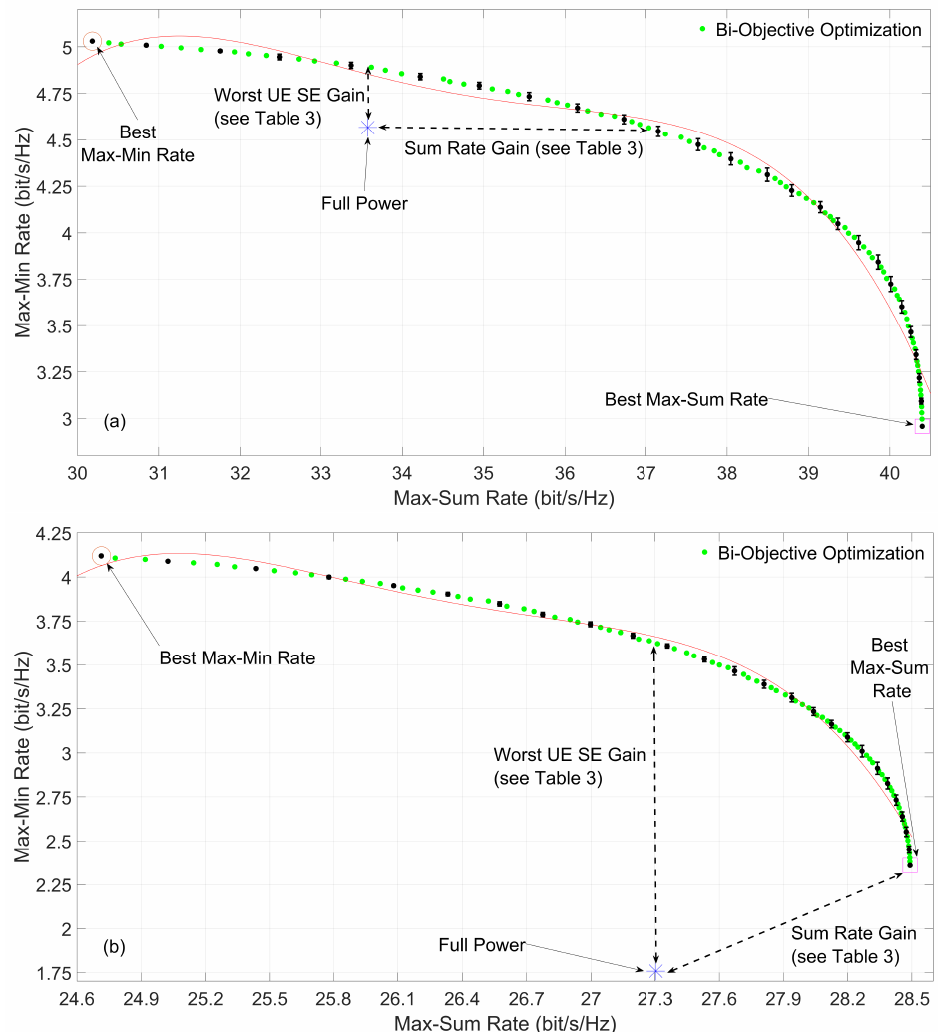
Figure 4. Bi-objective power optimization, max–min fairness and max–sum rate OF in a low UE density RS network with ( a ) high and ( b ) low maximum